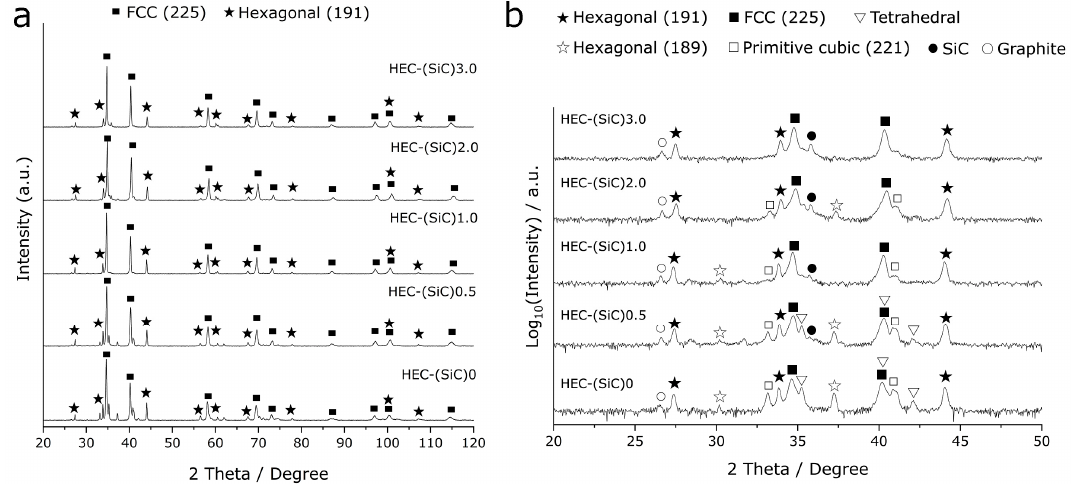
Figure 5. ( a ) X-ray diffractogram of HEC-(SiC)x composites sintered at 2000 °C (the corresponded space groups are marked in the bracket), ( b ) the intensities are plotted in logarithmic scale. The reduction of the number of the phases in the composites can be observed with increased SiC content.